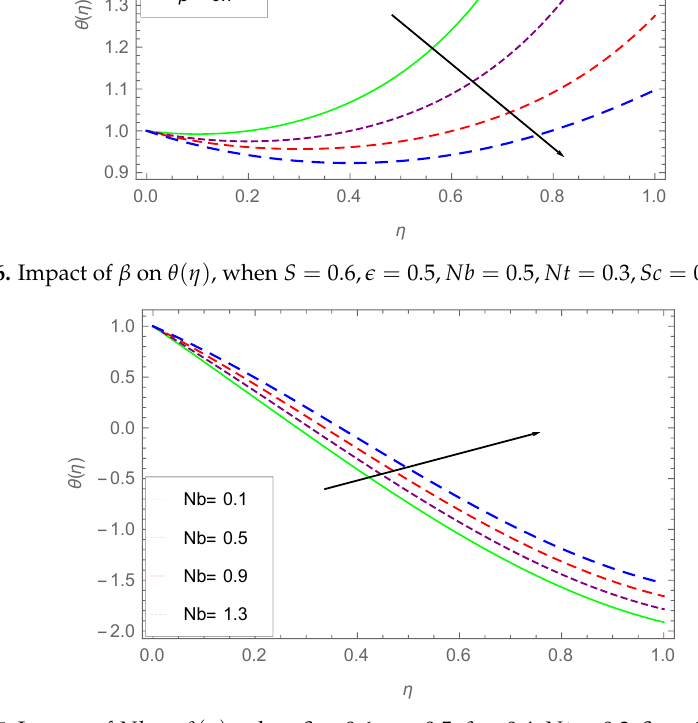
Figure 7. Impact of Nb on θ ( η ) , when S = 0.6, (cid:101) = 0.5, β = 0.4, Nt = 0.3, Sc = 0.1, Pr = 0.7.